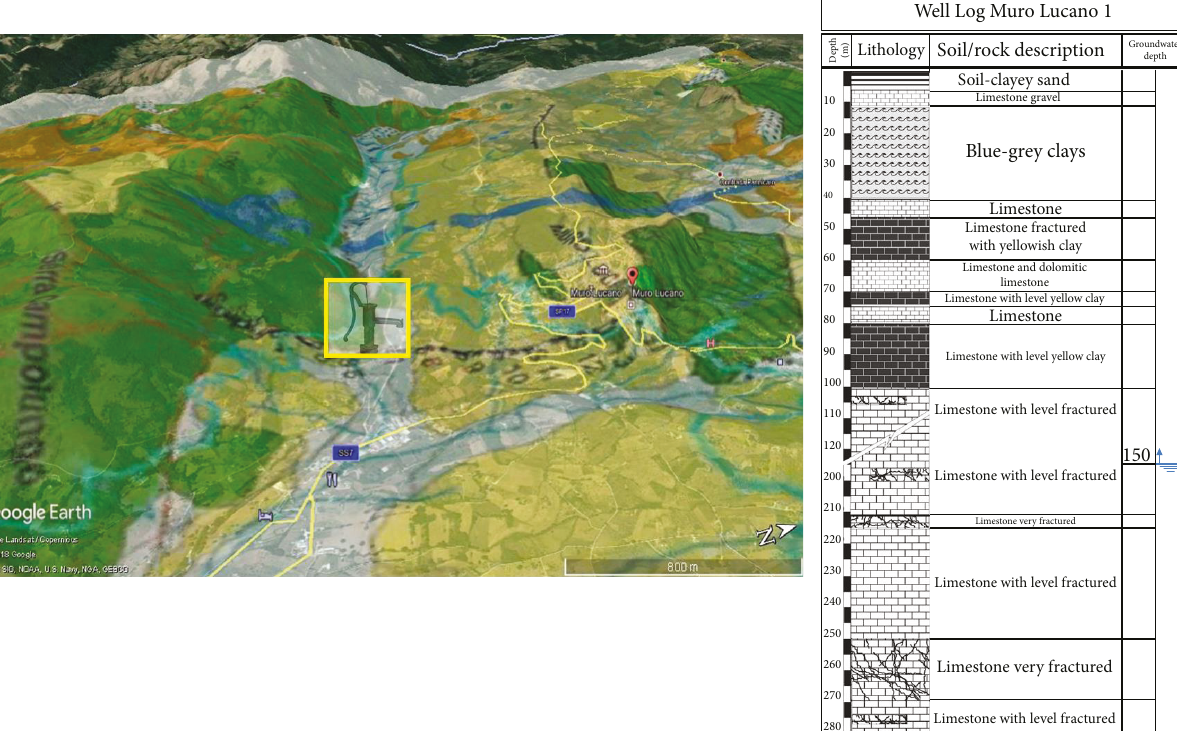
Figure 6: The hydrogeological map and the well log of the Muro Lucano 1